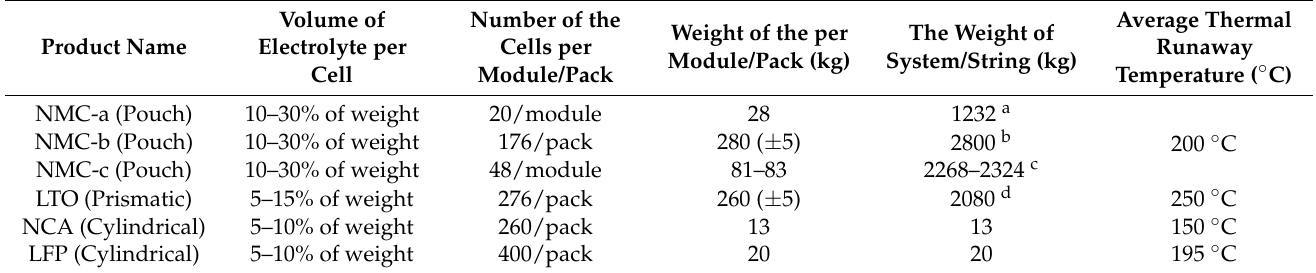
Table 1. Technical characteristics of the cells and LIBs used in Exp. A.